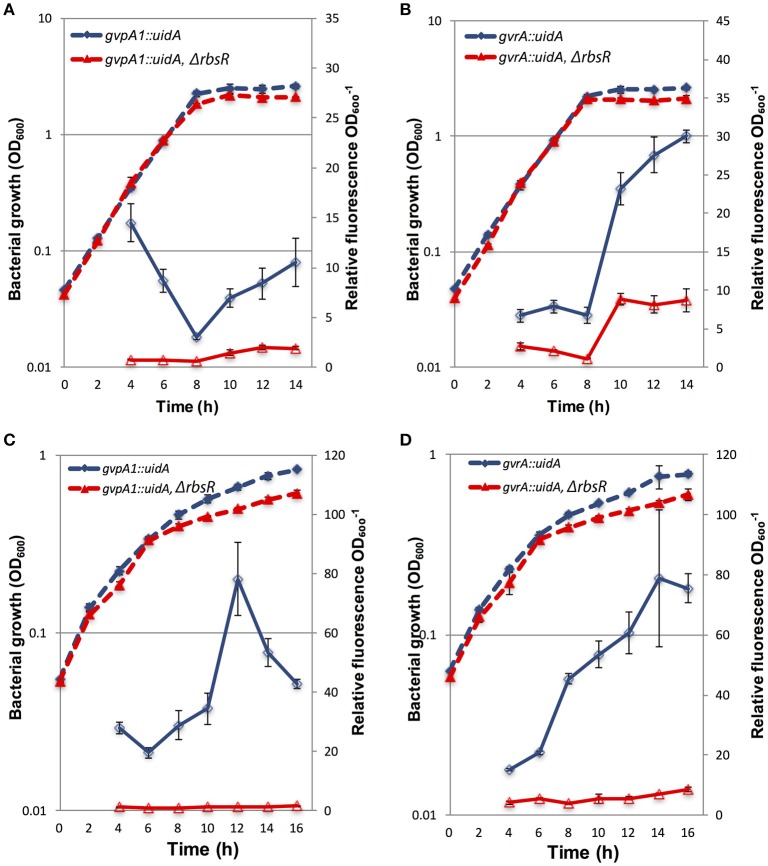
The expression of gvpA1 and gvrA in wild type and rbsR backgrounds under aerobic and microaerophilic conditions. β-glu activity from a chromosomal gvpA1::uidA fusion strain was assayed in wild type (blue) and the rbsR mutant (red) under (A) aerobic or (C) microaerophilic conditions. β-glu activity was measured from a chromosomal gvrA::uidA fusion in the wild type (blue) and rbsR background (red) under (B) aerobic or (D) microaerophilic conditions. Solid lines represent β-glu assays, dashed lines represent the optical density (OD600) of wild type and the rbsR mutant. Data shown are mean values ± SD (n = 3). ANOVA two-factor analysis comparing β-glu activity of the indicated fusion in wild type to the rbsR mutant throughout growth in (A) found F = 1344.01 > Fcrit = 4.20, p = 3.28*10−25; in (B)
F = 1027.51 > Fcrit = 4.20, p = 1.29*10−23; in (C)
F = 990.65 > Fcrit = 4.20, p = 2.13*10−23; and in (D)
F = 464.83 > Fcrit = 4.20, p = 5.61*10−19.